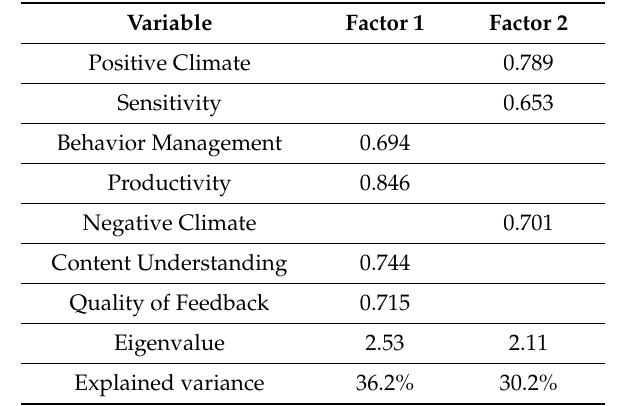
Table 4. Results of factor analysis after Varimax rotation (two-factor solution): values represent factor loadings for the assessments.